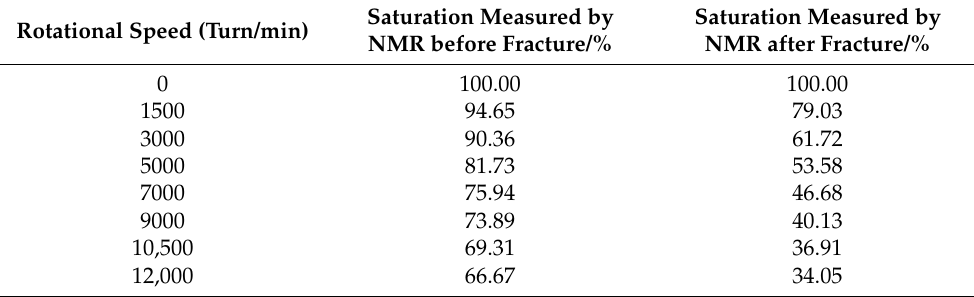
Table 3. Changes of water saturation at different rotational speeds before and after